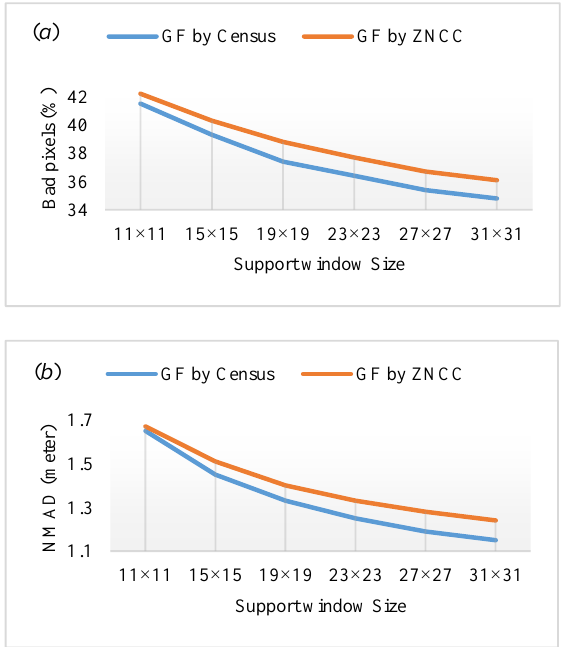
Figure 2: Evaluation of GF method by selecting different support windows. The vertical axis of the figure (a) denotes the percentage of Bad-pixels and the figure (b) represents the metric of